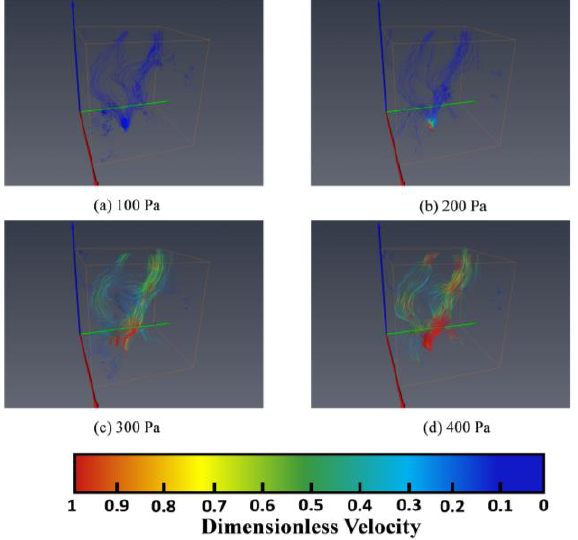
Figure 12. Velocity distributions of two-phase flow (nonwetting phase–CO 2 , wetting phase–brine) in the tighter REV when P diff is equal to 100 Pa ( a ),200 Pa ( b ),300 Pa ( c ),400 Pa ( d ) at S CO2 = 0.5, Ca = 1 × 10 − 4 , M = 10 and WI = 0.7.